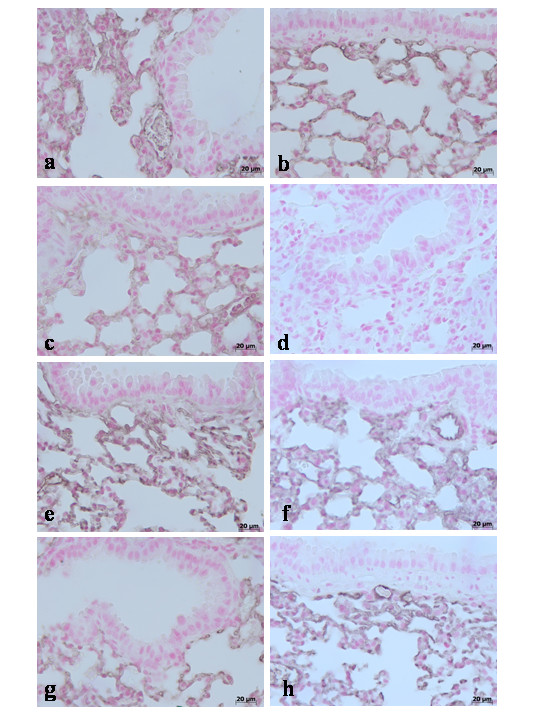
Immunohistochemical localization of Claudin-5 in the lung. In lung tissue sections collected at 24 hours from sham WT mice (a) and from sham TNF-αR1KO mice (b), Claudin-5 were uniformly and continuously distributed along the alveolar epithelium and the vascular endothelium. On the contrary, a significant disruption of immunohistochemical localization signal for Claudin-5 was observed in the lung tissues sections of carrageenan-treated WT mice at 4 h (c) and at 24 hours (d) after carrageenan. In lungs of carrageenan-treated TNF-αR1KO mice was found less irregular distribution pattern of Claudin-5 at 4 h (e) and at 24 hours (f) after carrageenan. Similarly, the treatment of WT mice with Etanercept (5 mg/kg administered s.c. 2 h prior carrageenan) were able to prevent carrageenan-induced distribution alteration of Claudin-5 at 4 h (g) and at 24 hours (h) after carrageenan. Figure is representative of at least 3 experiments performed on different experimental days.